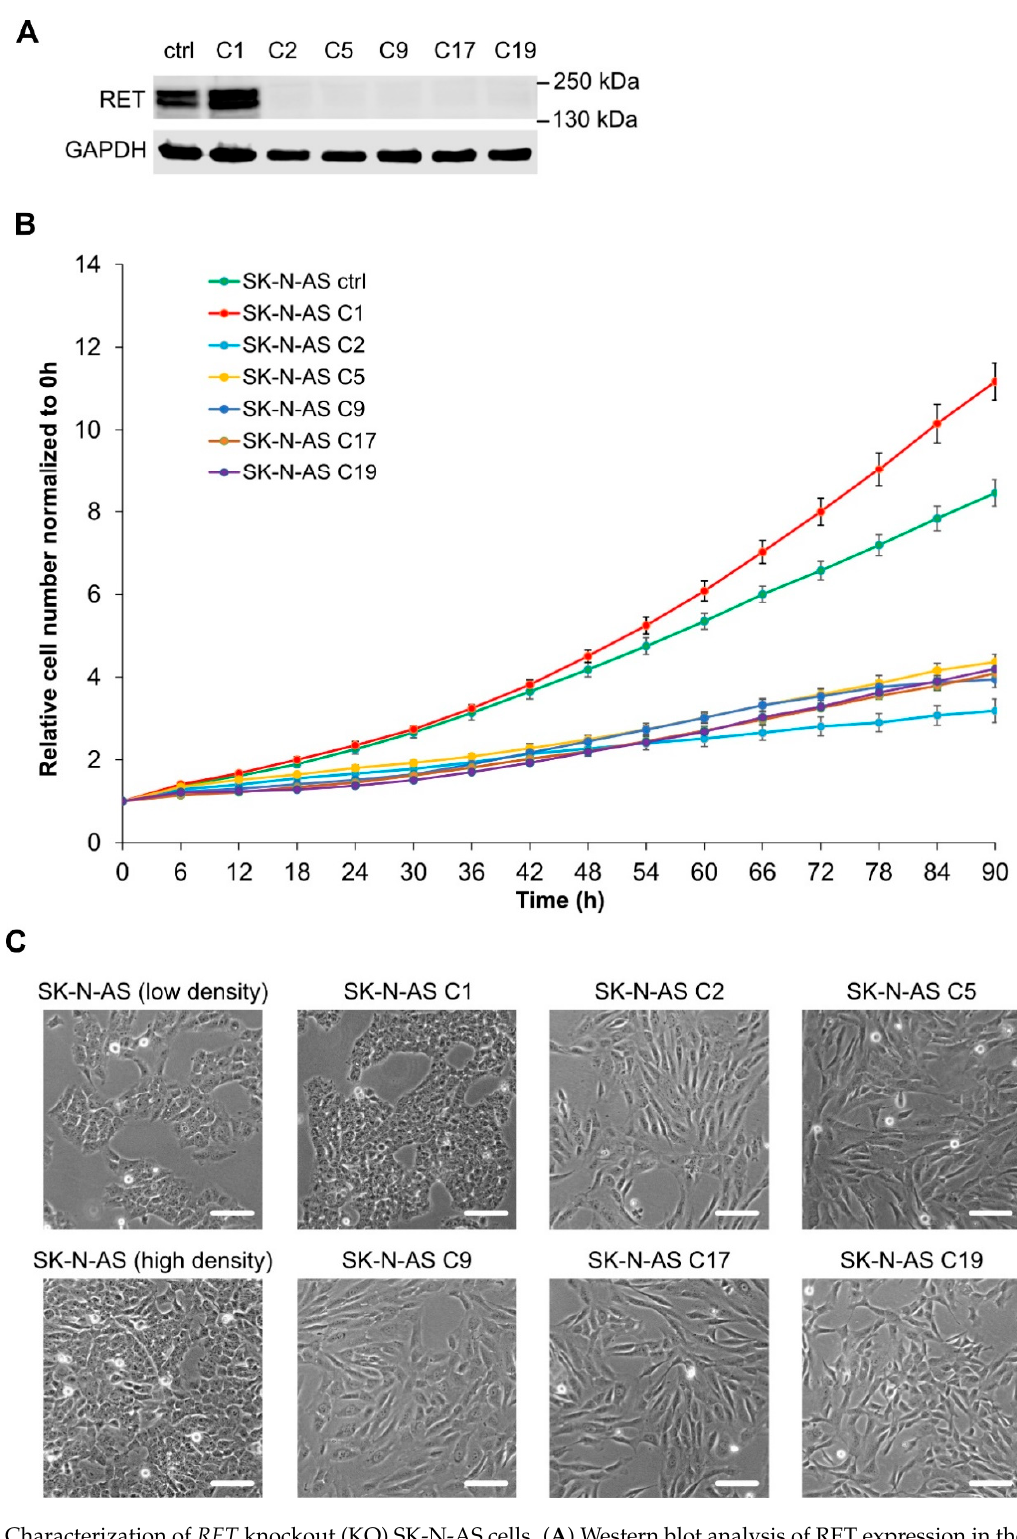
Figure 4. Characterization of RET knockout (KO) SK-N-AS cells. ( A ) Western blot analysis of RET expression in the parental (ctrl) and multiple clones of RET CRISPR/Cas9 engineered SK-N-AS cells. GAPDH was used as loading control. ( B ) Cell proliferation analysis of RET CRISPR/Cas9 engineered SK-N-AS cells with Incucyte S3 Live-Cell Analysis System and Nuclight Rapid Red Dye for live-cell nuclear labeling. ( C ) Bright-field microscopy images of indicated cells indicating morphological differences observed in RET CRISPR/Cas9 engineered SK-N-AS cells (scale bar = 50 μ m).